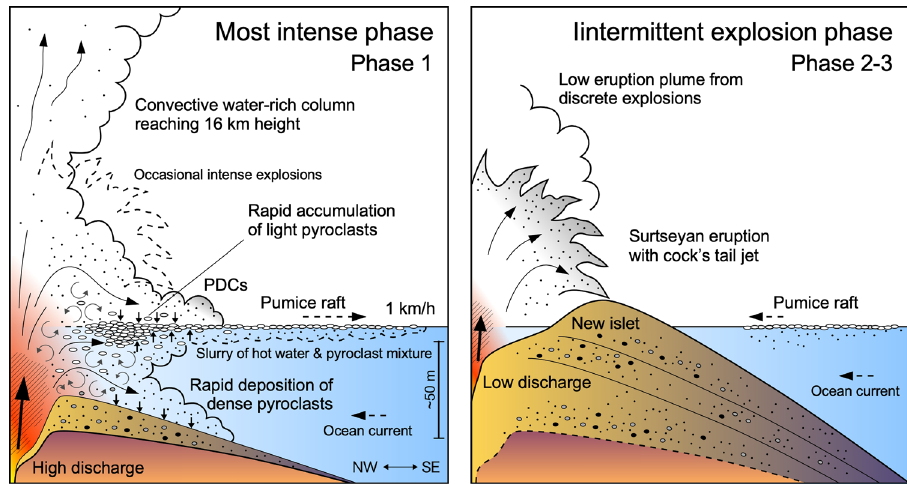
Fig. 5 Idealised near-source processes of the phreatomagmatic explosions during the 2021 FOB eruption. Surtseyan eruptions in the later intermittent phase might have been controlled by the availability of external water vs. shallow eruptions with lower mass discharge rate, due to the build-up of the